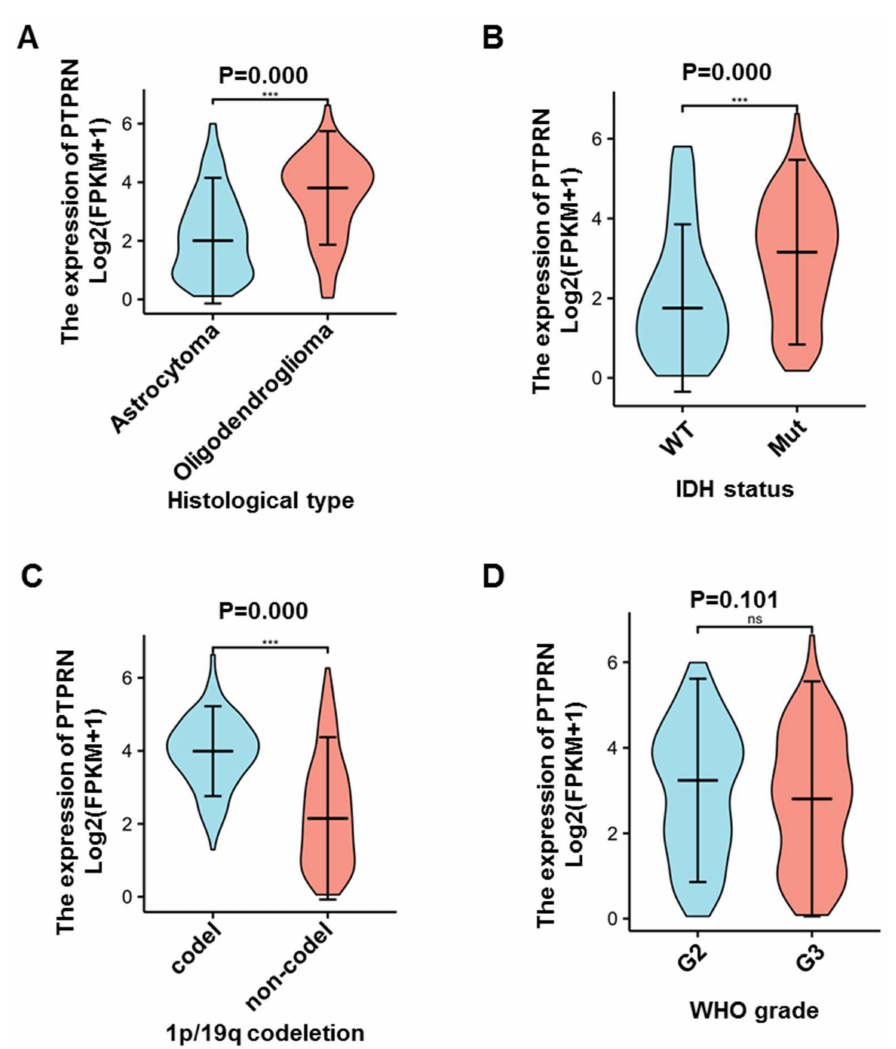
Figure 2. The associations between PTPRN mRNA expression and clinic characteristics. ( A ) In oligo-